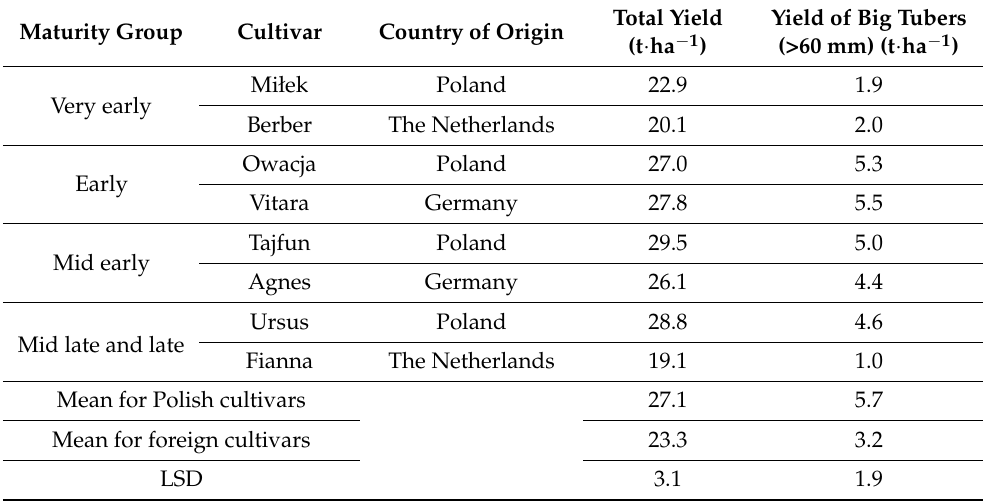
Table 2. Tuber yield and its structure of Polish and foreign cultivars cultivated in an organic system (Jadwisin, 2008–2010).